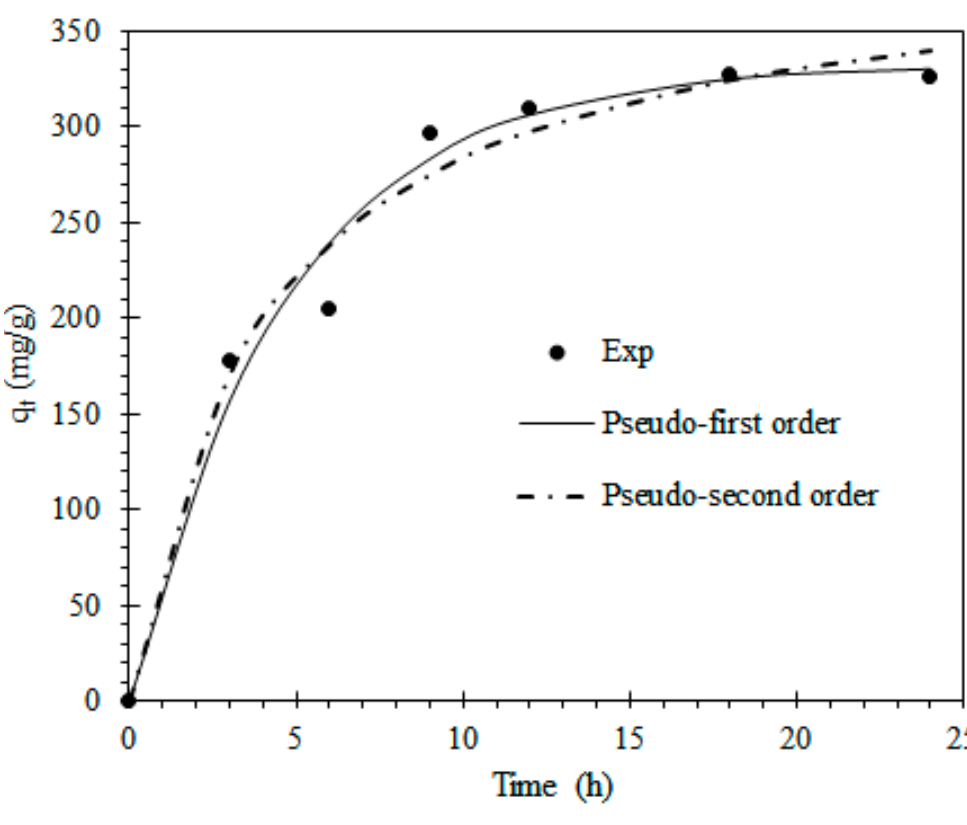
Figure 8. Kinetic plots for COD removal by bagasse. Table 7. Parameters and error functions data for kinetic models studied obtained from non-linear regression forms.